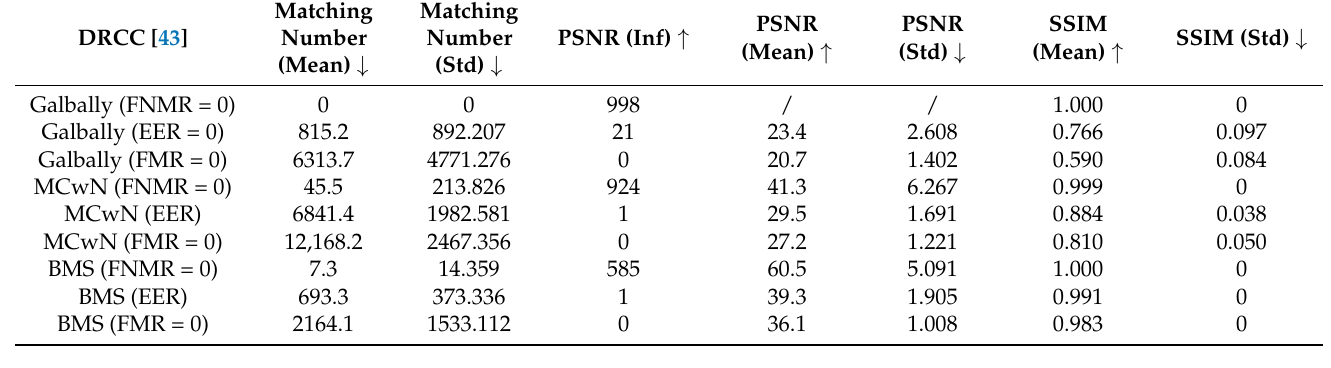
Table 10. Attack performance of DRCC [43].